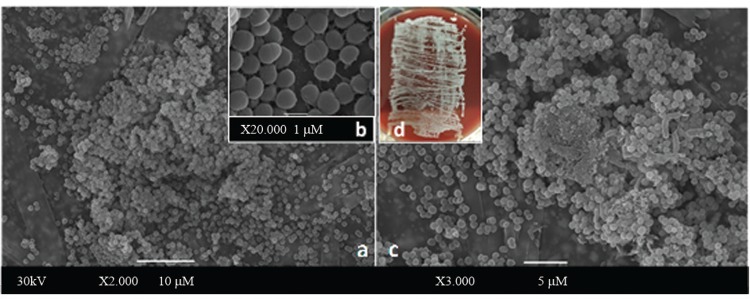
: biofilm formation on polyurethane catheter surfaces by oxacillin-resistant Staphylococcus haemolyticus (ORSH) isolated from fomites, verified by (A-C) scanning electron microscopy (SEM) assays and the roll plate Maki technique (D). After 24 h of incubation, the ORSH 11SF/9E3/06 [pulsed-field gel electrophoresis (PFGE) type G2; icaAD-positive] strain isolated from a sphygmomanometer used in the neonatal intensive care unit-Pedro Ernesto University Hospital-University of the State of Rio de Janeiro (ICU-HUPE-UERJ) (A) and grown in the absence of antibiotics produced a large amount of mature biofilm characterised by hollow voids on the luminal surface of the indwelling medical device; (B) detailed bacterial microcolonies indicative of a biofilm-producing pathogen; (C) biofilm production on catheter surfaces in the presence of ¼ minimal inhibitory concentration (MIC) of vancomycin (VA); (D) the roll plate assay indicated viable ORSH cells were extensively adherent (> 106 CFU) to and able to multiply on polyurethane catheter surfaces.